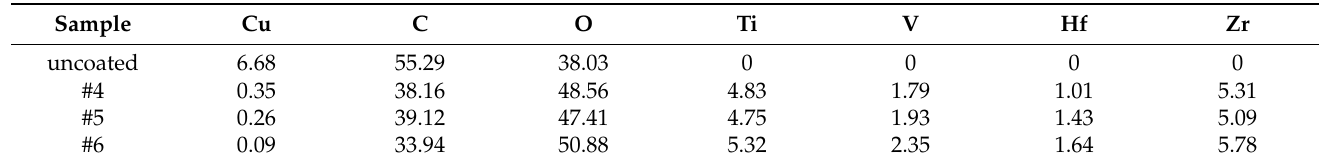
Figure 6. The XPS spectra of ( a ) uncoated (black) open-cell copper foam with pore size of 300 μ m, Ti-Hf-V-Zr NEG film coated open-cell copper foam (Sample #4, red), (Sample #5, blue), and (Sample #6, Green); ( b ) the XPS survey scan of Cu, C, O, Ti, Hf, V, and Zr in the Ti-Zr-V-Hf film with foamed porous copper substrates. Table 2. XPS (at%) analysis for quantification of the concentrations of the copper foams with pore size of 300 μ m before and after coating.